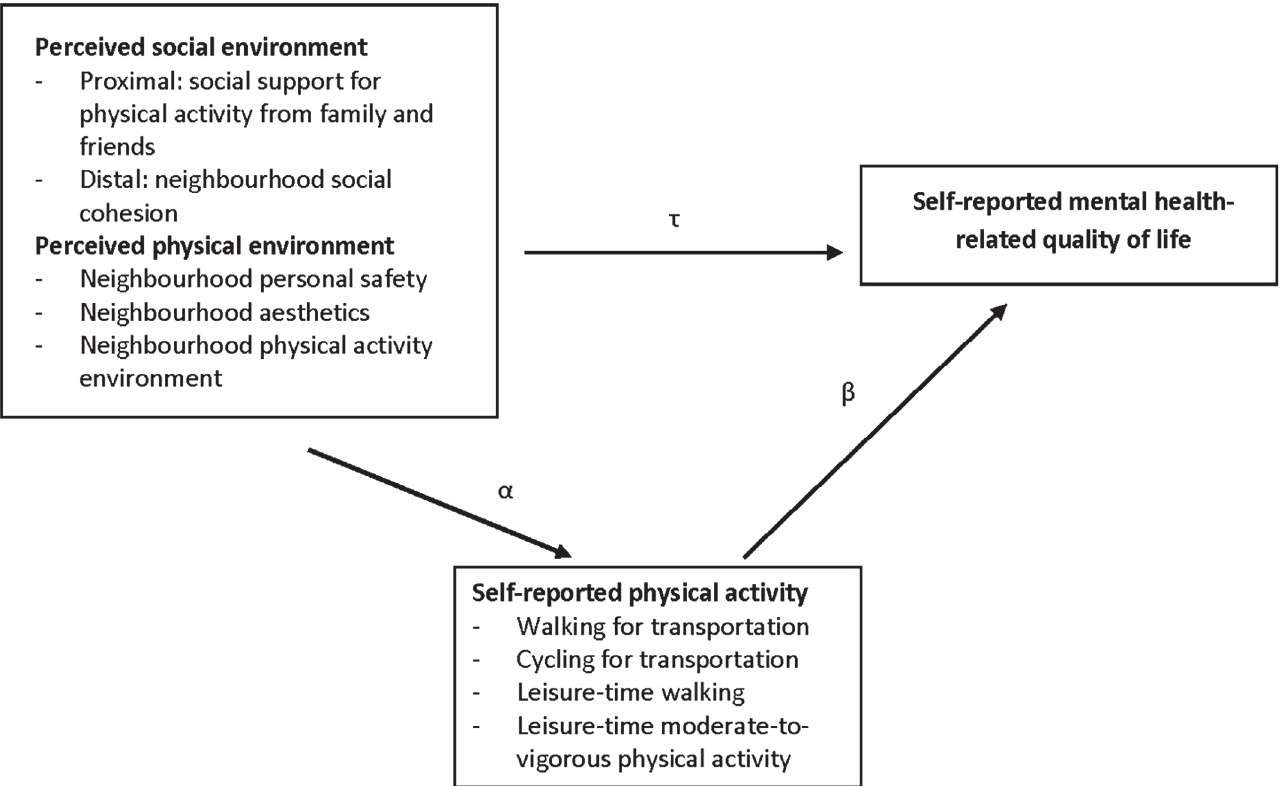
Fig 1. Conceptual model of pathways and variables examined through the mediation analyses. τ = main associations between the physical/social environmental perceptions and mental health-related quality of life. α = associations between the physical/social environmental perceptions and